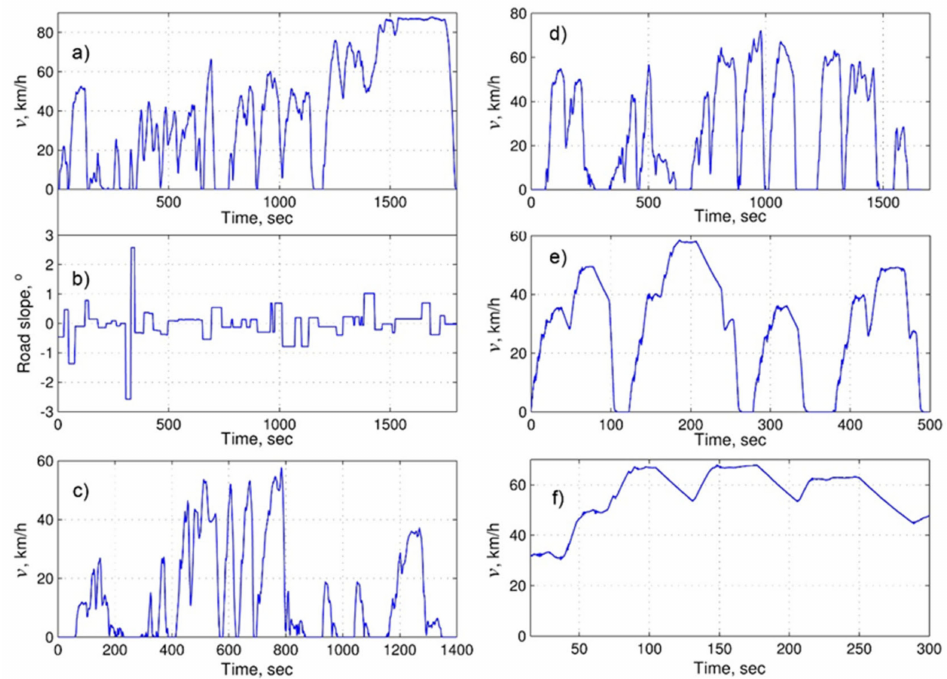
Figure 11. Driving cycles employed in the simulations. ( a , b ) velocity and road slope of the World Harmonized Vehicle Cycle (WHVC), ( c ) the West Virginia University city cycle (WVUCITY), ( d ) the West Virginia University suburban cycle (WVUSUB), ( e ) the GOST city cycle (GOST city), ( f ) the GOST highway cycle (GOST